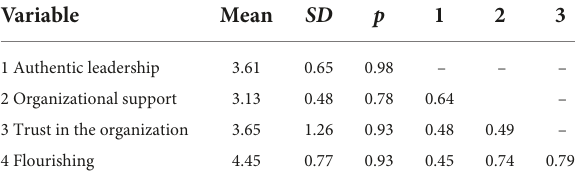
TABLE 2 Descriptive statistics, reliabilities, and correlations of the scales. Variable